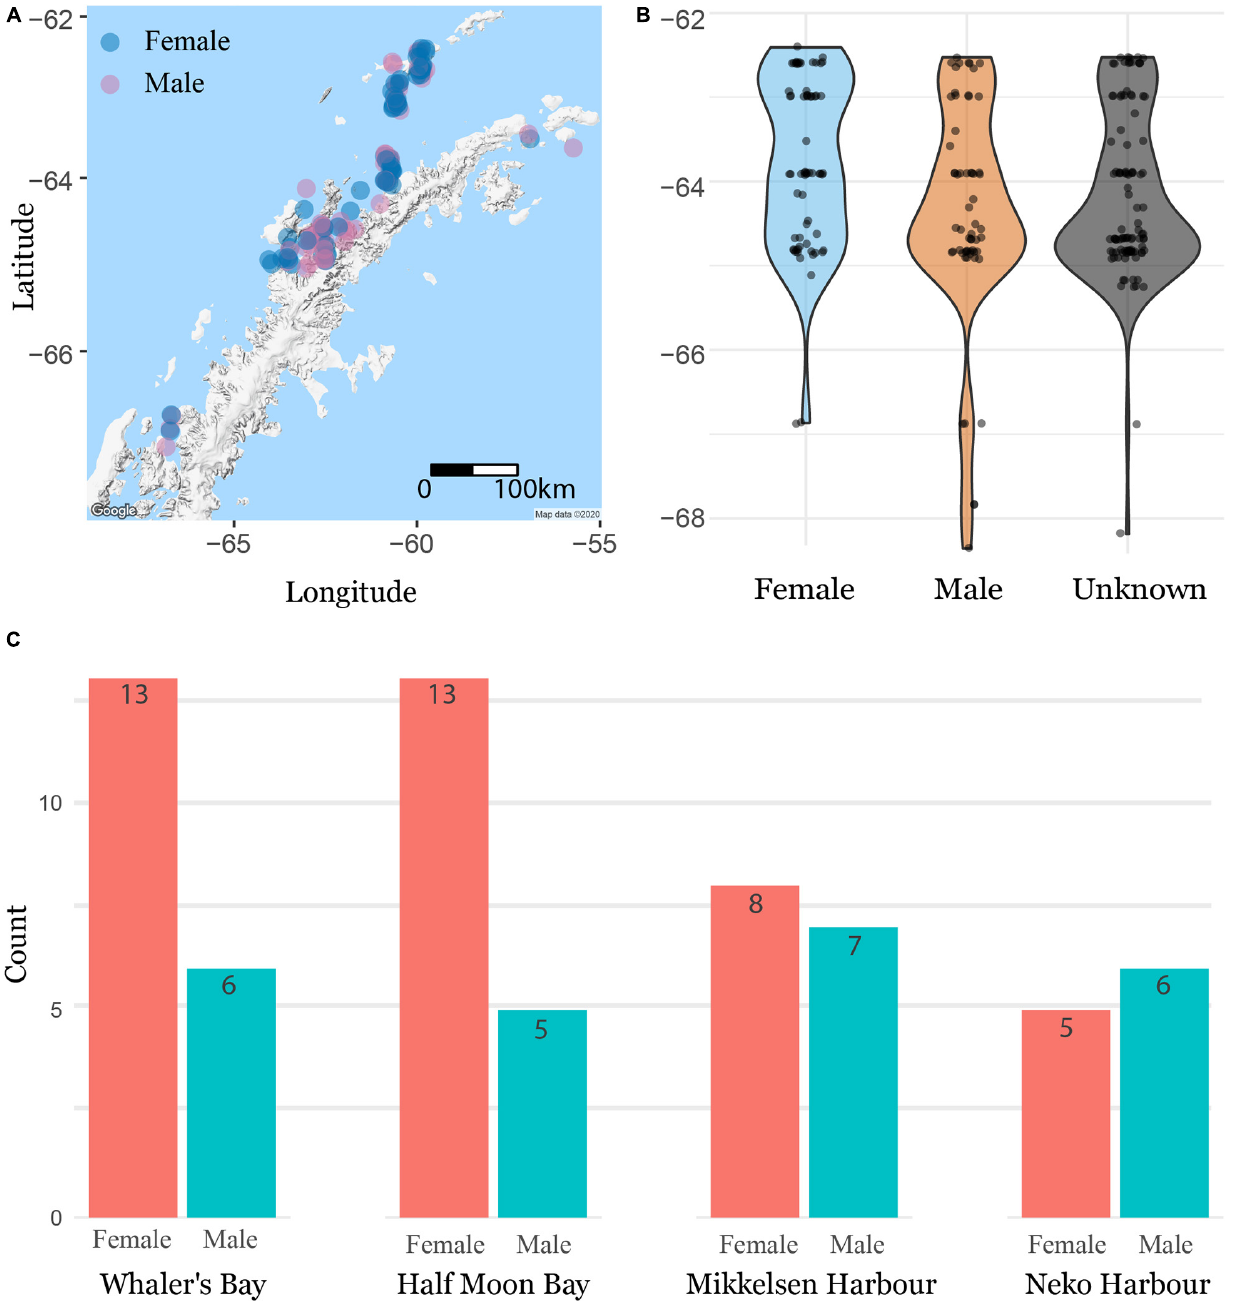
FIGURE 5 | (A) Male/female distribution across the region. (B) Latitudinal distribution by sex. (C) Site-level sex